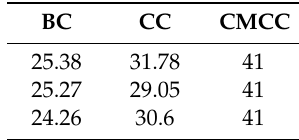
Table 3. Angle of repose for BC, CC, and CMCC.